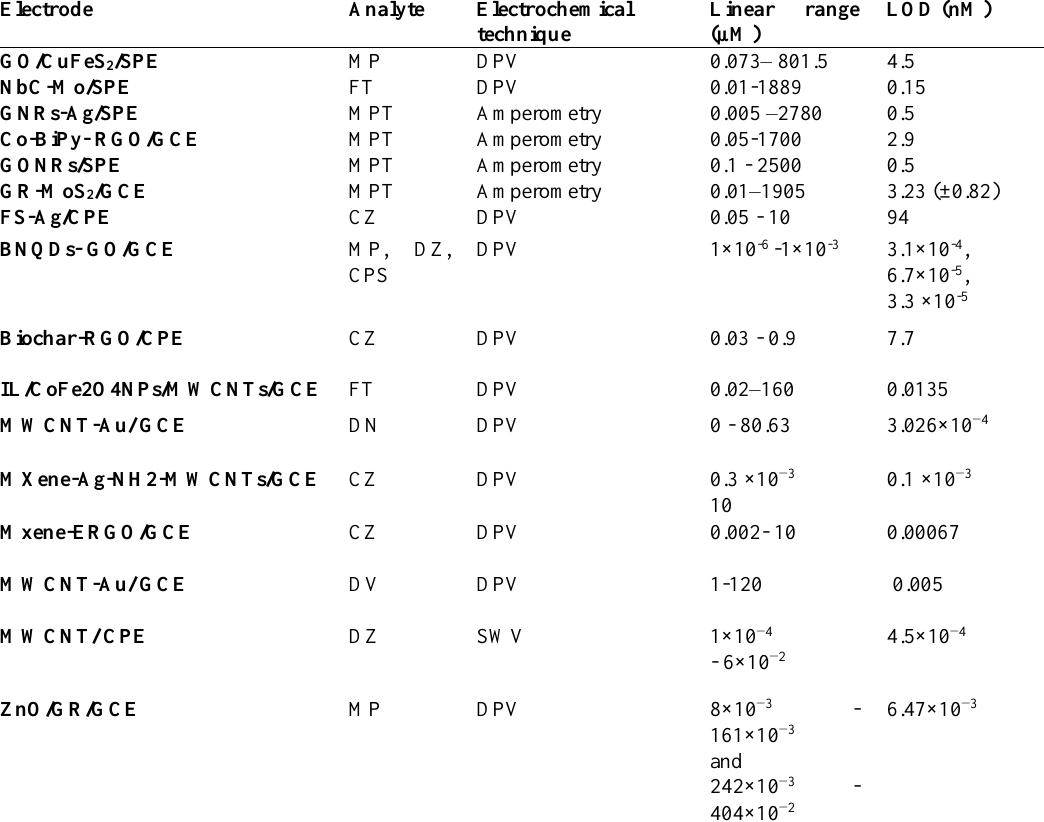
Electrode Analyte